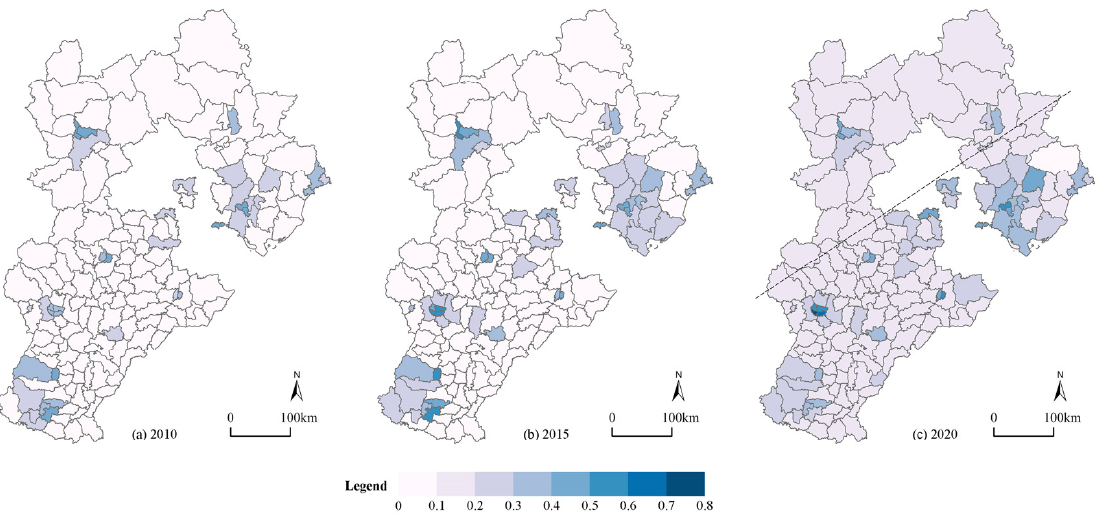
Figure 3. Spatial distribution of the urbanization of 167 counties in Hebei. ( a ) Urbanization in 2010; ( b ) urbanization in 2015; ( c ) urbanization in 2020.